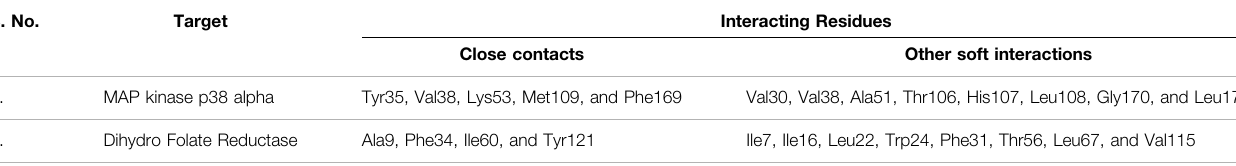
TABLE 2 | List of interacting residues of MAP kinase p38 alpha and DHFR to CIN. S.